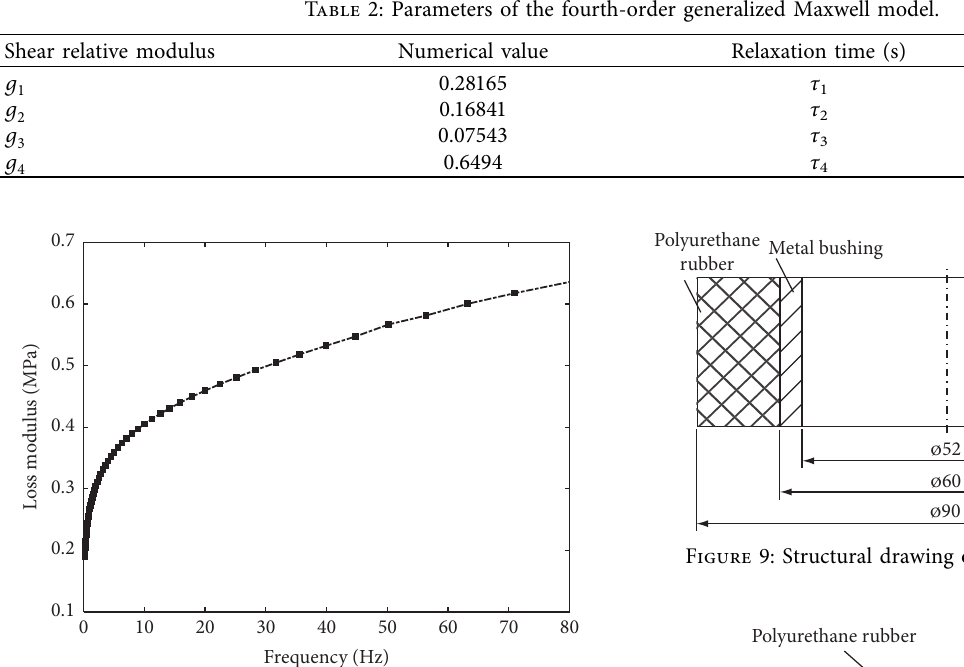
Figure 7: Loss modulus-frequency test curve of polyurethane pieces.